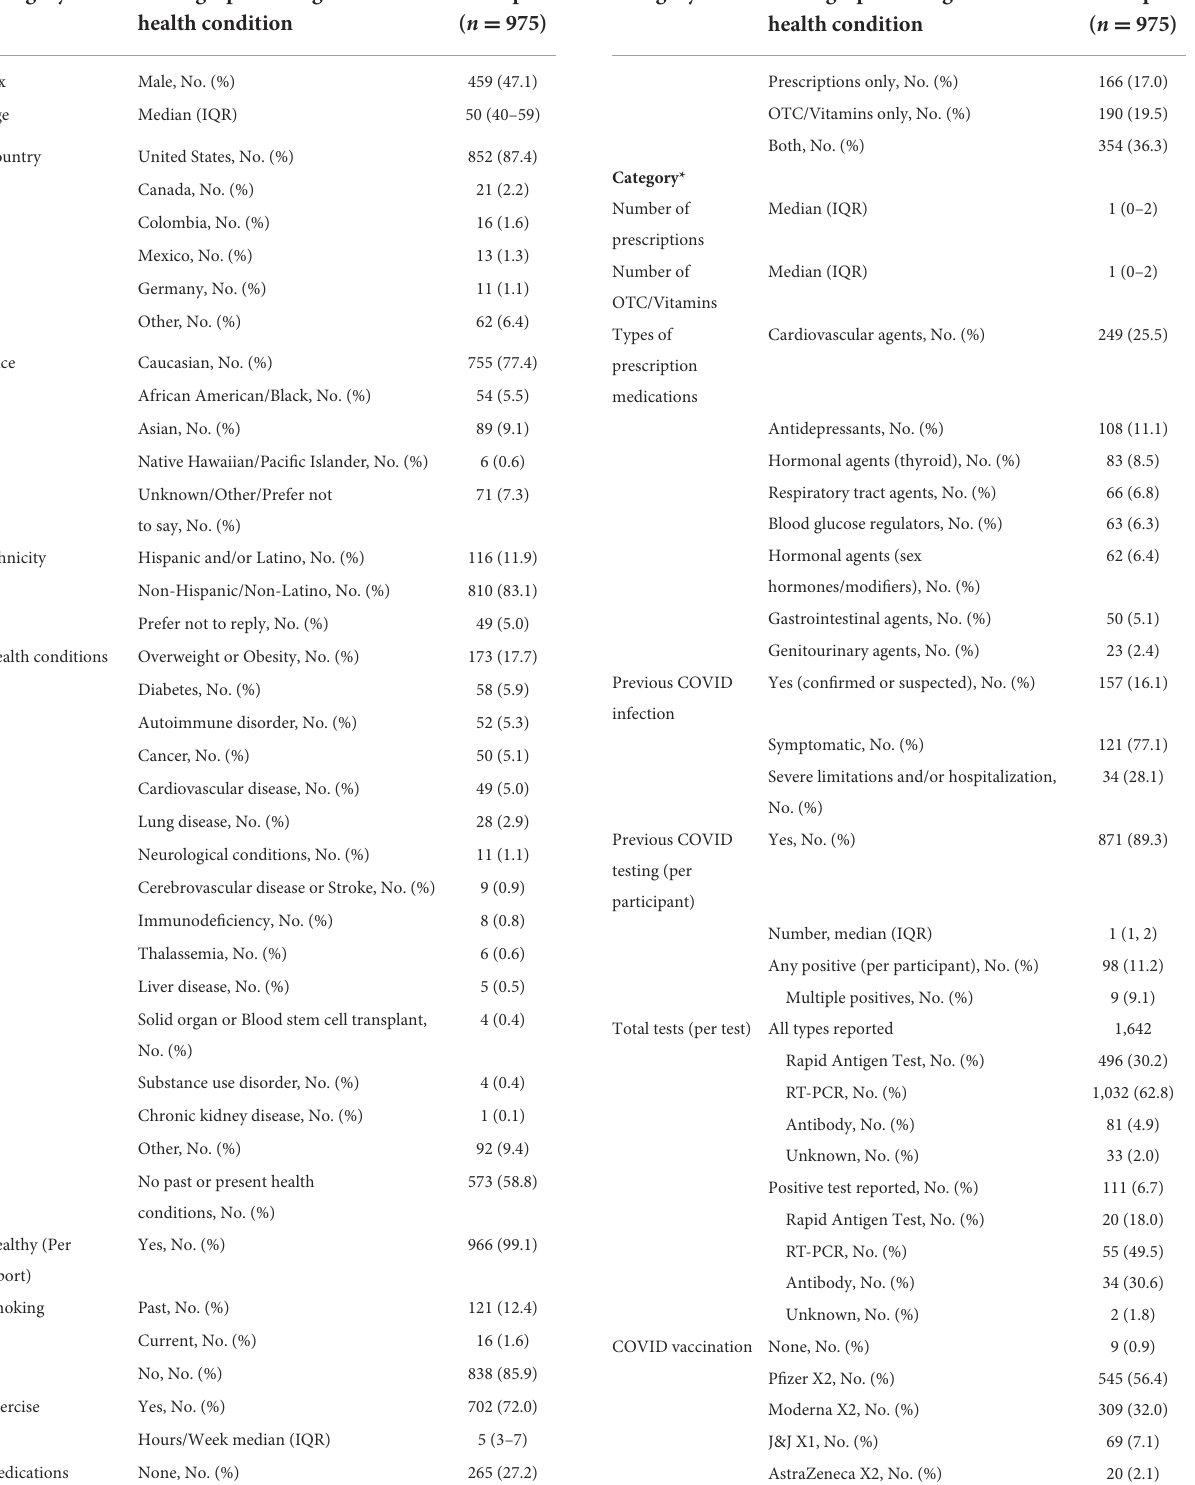
TABLE 1 Survey participant demographics, general health conditions, and COVID-19